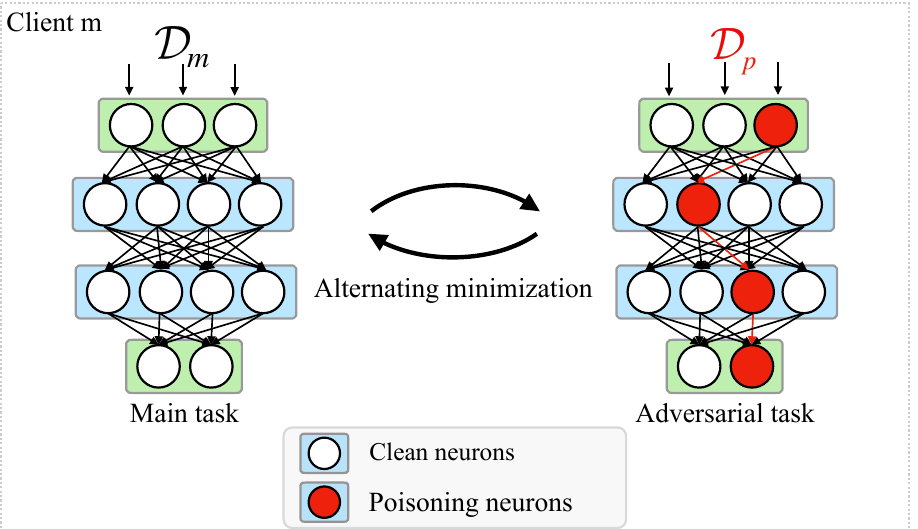
Figure 3. Schematic illustration of poisoning neurons selection and injection. The attacker elaborately selects a sequence of neurons (red circle) that are hardly changed during main task to perform adversarial